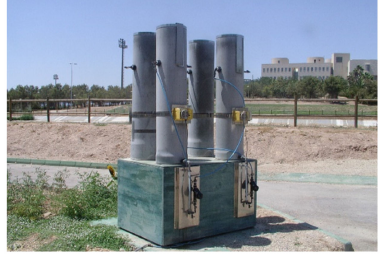
Figure 3. Picture of the pilot plant with horizontal